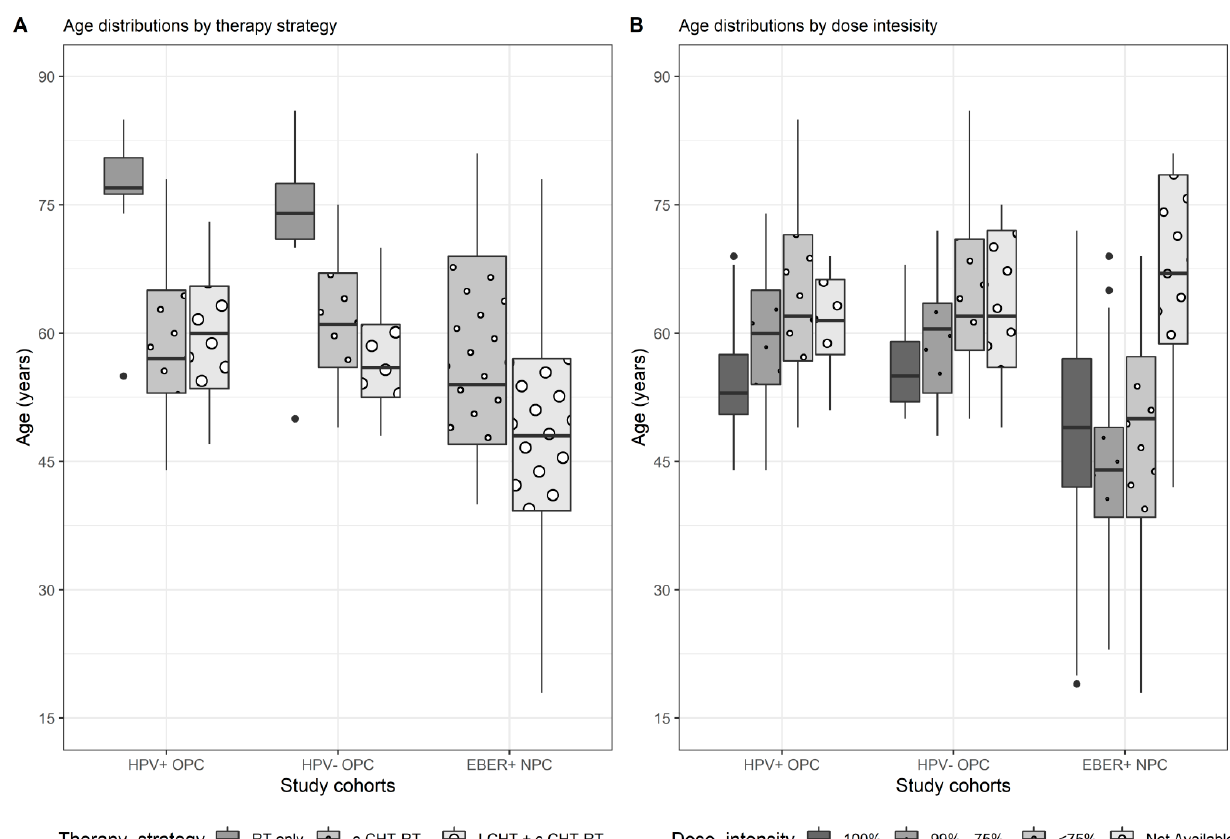
Figure 1. Age distribution by therapy strategy ( A ) and by categorized dose intensity ( B ). Abbreviation: Radiotherapy (RT); concurrent chemo-radiotherapy (RT+CT); induction chemotherapy followed by concomitant chemo-radiotherapy